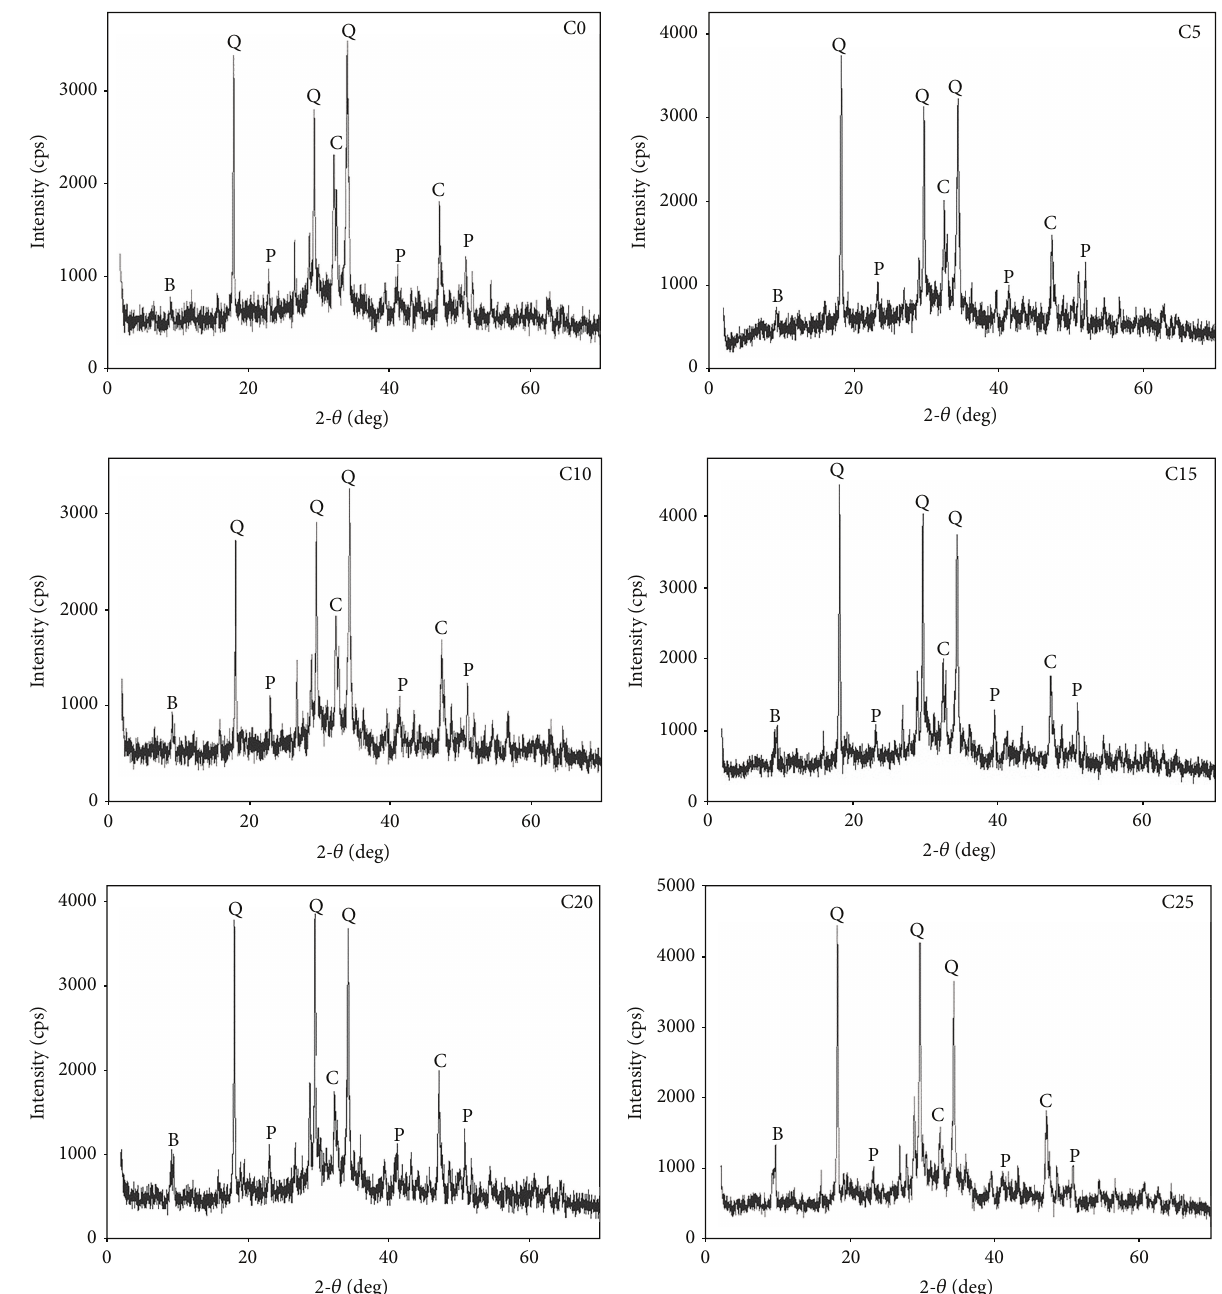
Figure 3: XRD patterns of C0, C5, C10, C15, C20, and C25 mortars. Q: quartz; C: calcite; P: portlandite; B: brucite.